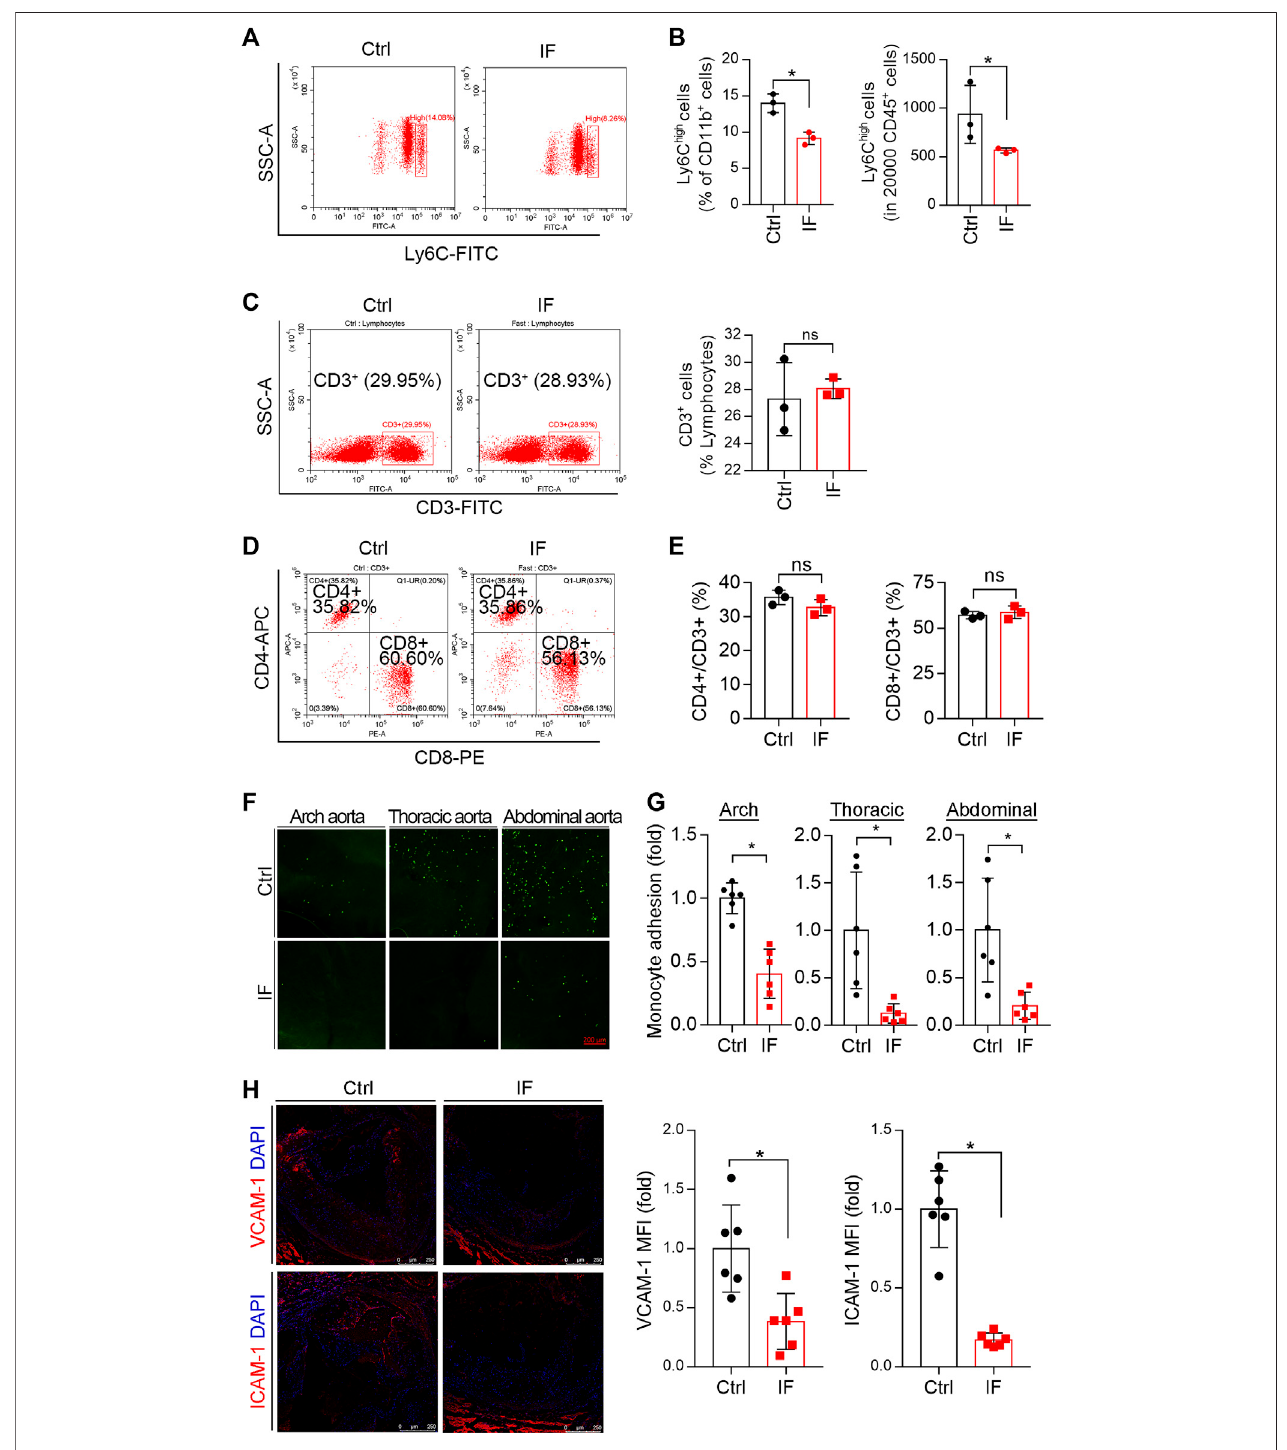
FIGURE 7 | Intermittent fasting reduces circulating monocytes and their adhesion to endothelium. LDLR − / − mice were divided into the control or IF groups ( n (cid:1) 6/ group).After2 weeksofHFDfeedingadlibitumorIFtreatment,mouseperipheralbloodandaortasampleswerecollected.MonocytesandTcellsinbloodsampleswere determined byFACS. (A – B) :In fl ammatory monocytes (CD11b + CD45+Ly6Chigh) weredetermined and quanti fi edin total CD11b +or CD45 + cells. (C – E) CD3 + (total Tcells),CD4 + Tcells,andCD8 + Tcells.* p < 0.05,ns:notsigni fi cant( n (cid:1) 3). (F,G) Archaorta,thoracicaorta,andabdominalaortaweredissectedfromthecollected aortas. Each of them were then cultured in complete DMEM medium containing CFSE-labeled THP-1 cells for 1 h. The adhering THP-1 cells were then captured by a microscope and quantitively analyzed. * p < 0.05 ( n (cid:1) 6). (H) The aortic root cross sections from mice in Figure 1 was used to determine the expression of VCAM-1 and ICAM-1 in plaques by immuno fl uorescent staining with quanti fi cation of VCAM-1 and ICAM-1 – positive areas. * p < 0.05 ( n (cid:1) 6).